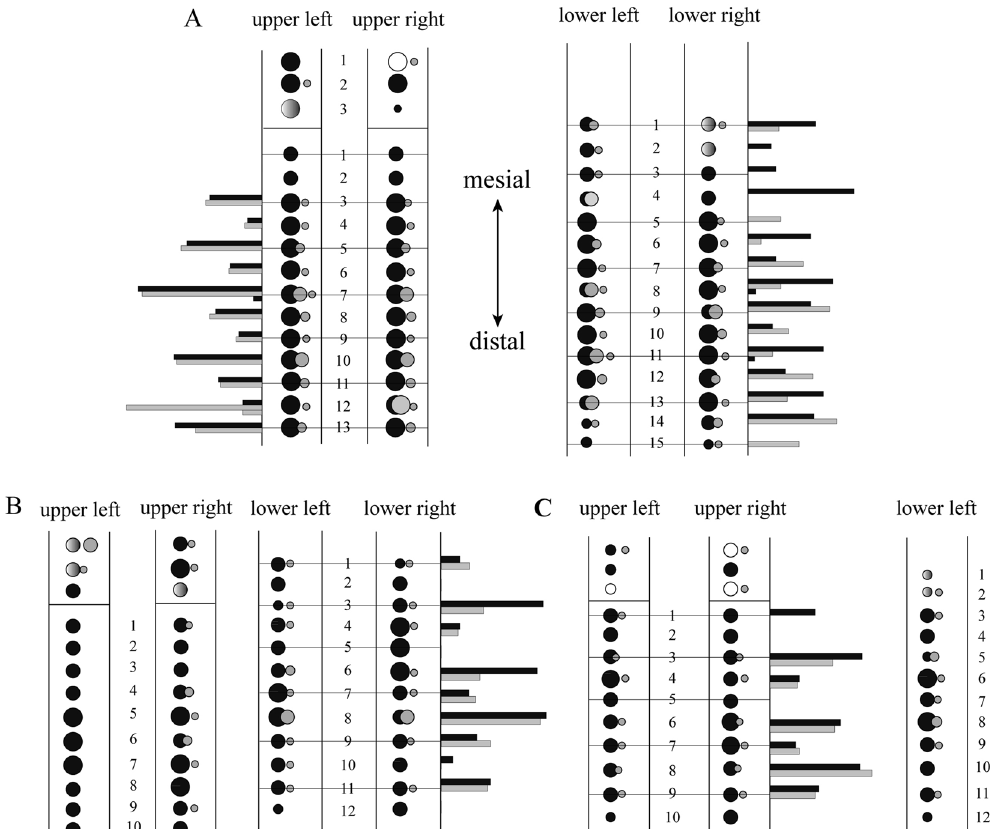
Figure 6. The tooth replacement process illustrated by teeth at different stages of eruption/replacement in the maxilla of the holotype. Elements in the CT reconstructions are colour-coded as follows: functional teeth, orange; replacement teeth, blue. Upper row, the functional teeth in lingual view, the corresponding replacement teeth are extracted separately to show their labial sides. Middle and lower rows, series of stages in the successional cycle seen in transverse sections in 3D construction and CT scans. Scale bars equal 5 mm. ( A ) A recently, fully erupted tooth crown (right tooth 4). ( B ) Growth of the replacement tooth and initiation of root resorption (right tooth 8). ( C ) Growth of successional tooth and the enlargement of the resorbed area on the functional tooth (right tooth 10). The arrows represent the the shallow grooves on mesial side. ( D ) Large part of functional root resorbed; tip of the successional tooth moving close to the functional tooth crown. In some tooth position, a second successional germ tooth makes its appearance (right tooth 7). ( E ) Functional